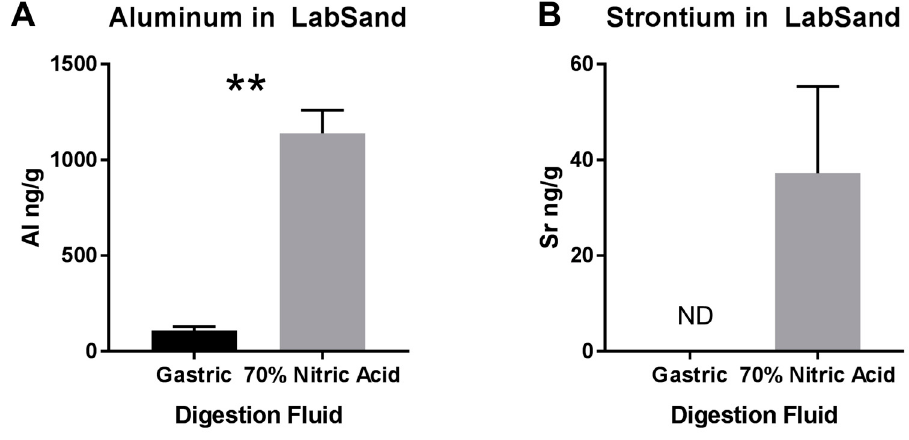
Figure 4. Digestion of LabSand brand hydrophobic sand in either synthetic gastric fluid or 70% nitric acid. ( A ) Aluminum and ( B ) Strontium extracted from LabSand under the two digestive conditions. ** p < 0.01, ND = not detected.